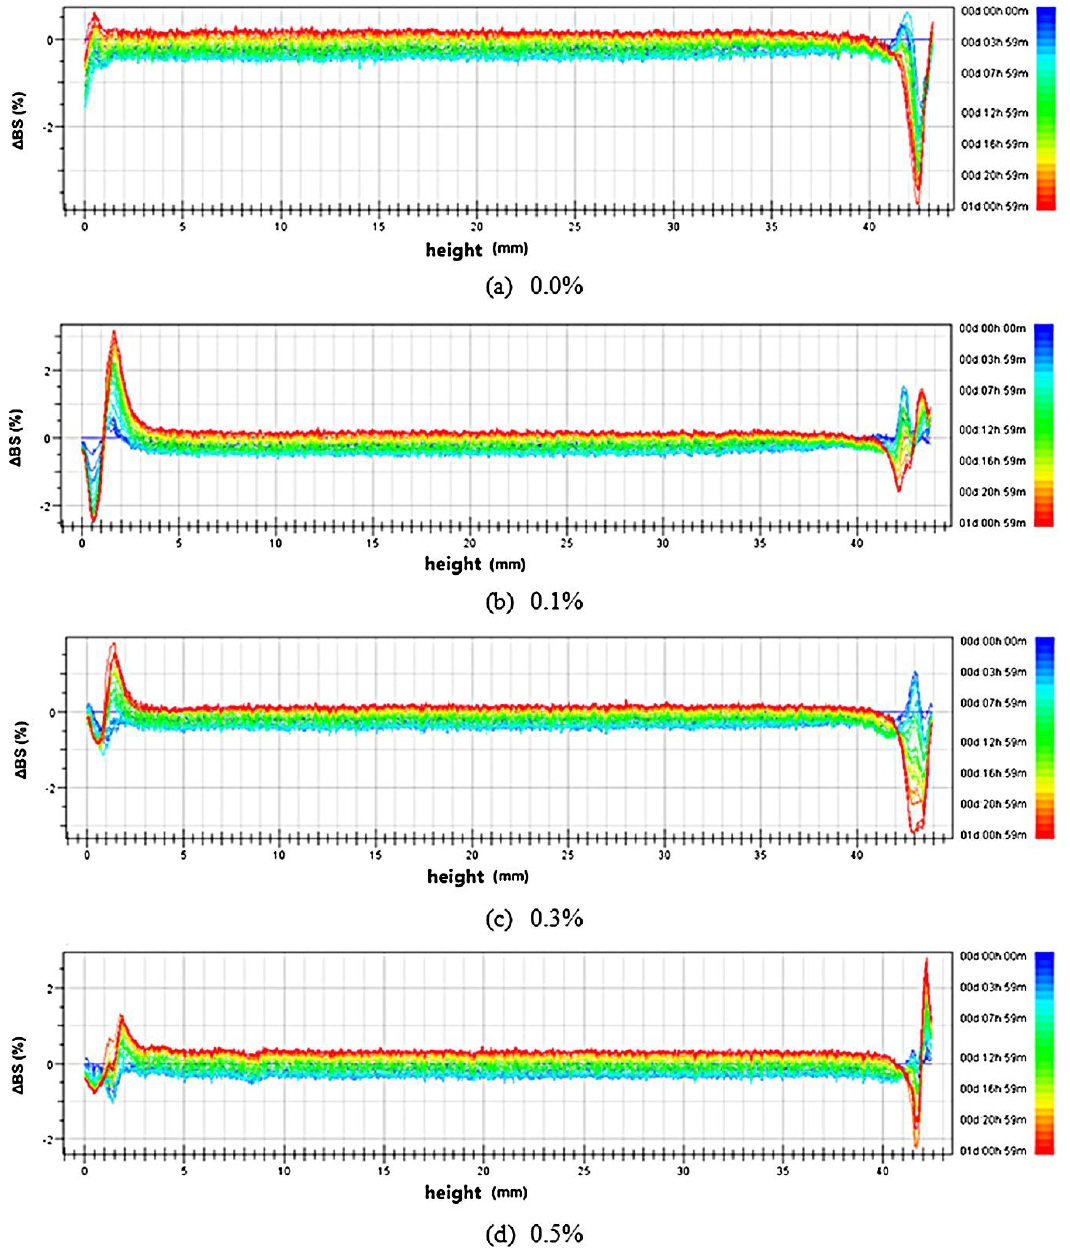
Figure 3. Effect of lycopene content ( a —0.0%, b —0.1%, c —0.3%, and d —0.5%) on the stability of nanoemulsions measured by Turbiscan ® 24 h. The lines of different colors represented the changes in the light back scattering over time [47].